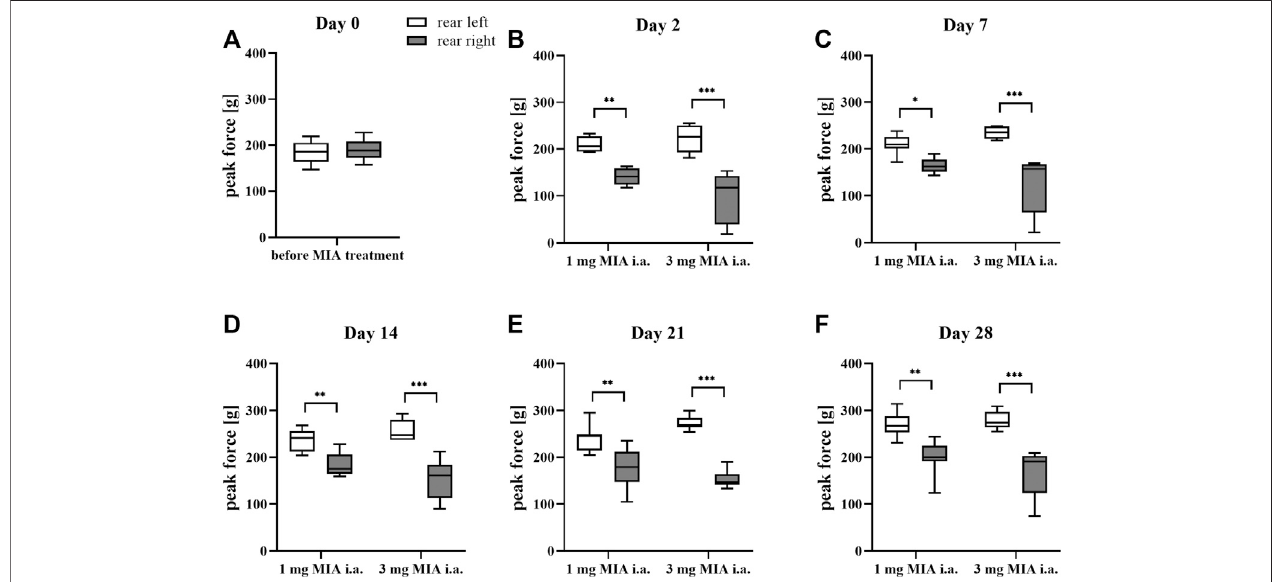
FIGURE 2 | Gait analysis in OA rats recorded with KWB by measuring the distribution of paw force applied to the ground during a free walk (for 1 and 3 mg of MIA i.a. groups) during a free walk. Measurements taken prior to the MIA injection (day 0; A ) and 2, 7, 14, 21, and 28 days (B – F) post-MIA treatment (n (cid:2) 5 – 8 animals per group). One-way ANOVA on day 0 or two-way ANOVA on the following experimental days and Tukey ’ s HSD post-hoc tests were performed. * denotes p < 0.05; ** denotes p < 0.01; *** denotes p < 0.001.